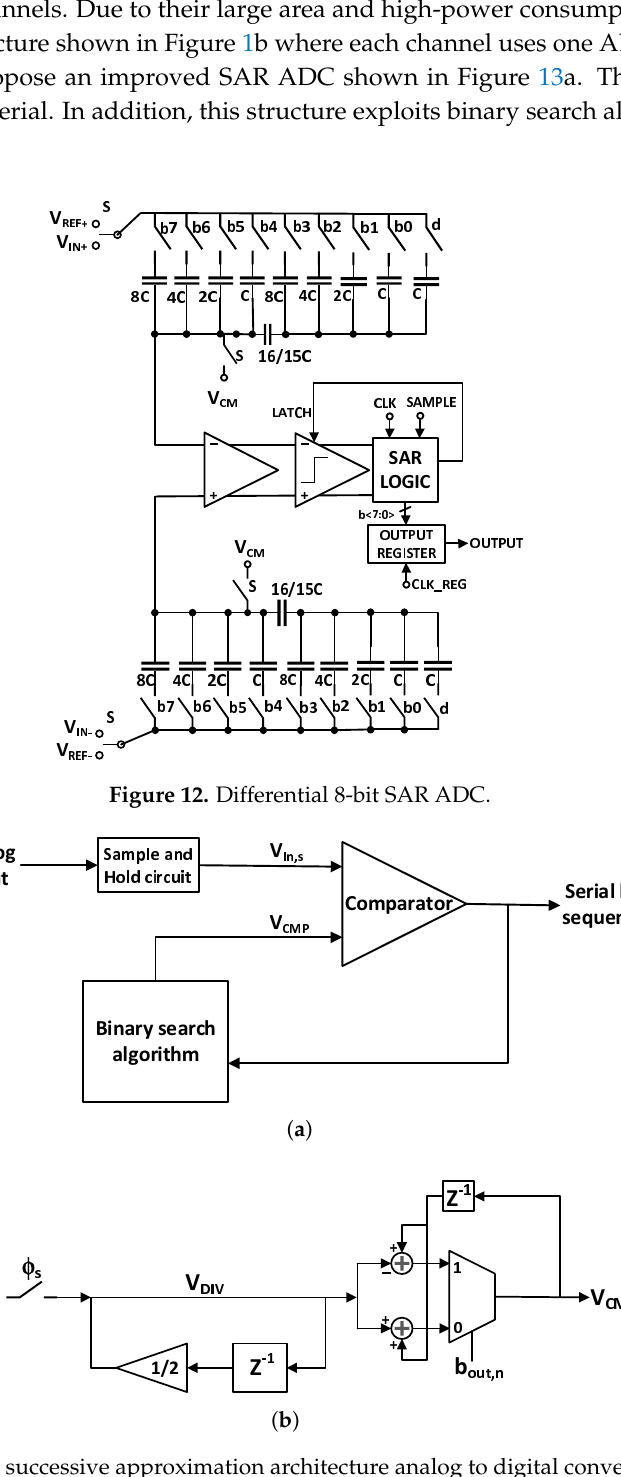
Figure 13. Modified successive approximation architecture analog to digital converters (SAR ADCs) for single-channel application. ( a ) Block diagram of the modified SAR ADC; ( b ) Schematic of binary search